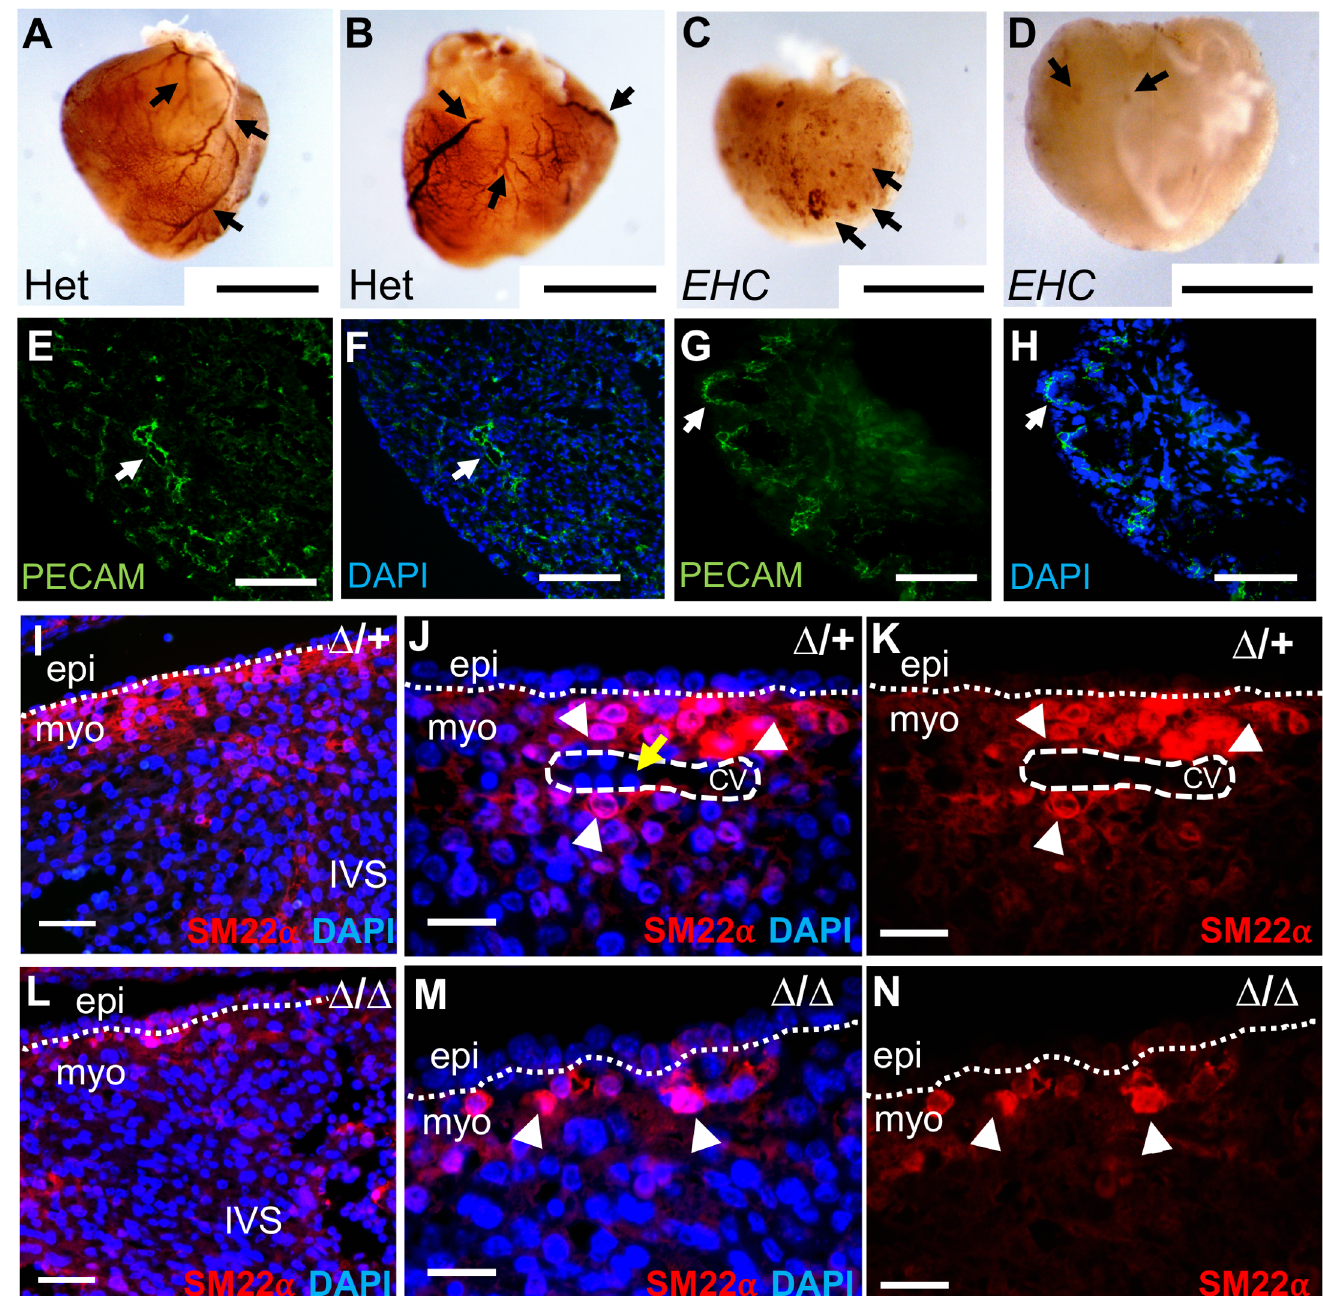
Fig 5. EHC mutants lack mature coronary vessels. PECAM-1 immunohistochemistry reveals prominent coronary vessels (arrows) on the ventral (A) and dorsal(B) surface of EHC heterozygous hearts. Only clusters of PECAM-1 expressingcells (arrows) are apparenton EHC homozygous mutant ventral (C) and dorsal (D) heart surface, with no clear evidenceof coronaryvessels. E-F: Section immunofluorescencefor PECAM-1 (green) on Myh10 Δ heterozygote at E14.5, demonstrating cells in myocardialregion surrounding a developingvessel (arrow). G-H: Section immunofluorescencefor PECAM-1 on Myh10 Δ homozygousmutant at E14.5, demonstrating stainingof clusters of cells on cardiac surface (arrow), consistent with wholemount stainingin panels C-D. Stainingfor the smooth muscle cell marker SM22 α revealsfew smooth muscle cells within the interventricular septum regionof the heterozygote (I) and Myh10 Δ homozygous mutant (L). SM22 α expressingcells are localisedarounda developing coronaryvessel (white dashed circle) in heterozygous control hearts (J-K, arrowheads),and nucleatedblood cells within the vessel can be visualisedwith DAPI (yellow arrow). No such structures are present in Myh10 Δ homozygous mutant hearts, and smooth muscle cells expressingSM22 α are less clusteredin mutant hearts (M-N, arrowheads). Cell nucleiwere labelledwith DAPI (blue). Scale bars: A-D = 1 mm, E-H = 100 μ m, I and L = 50 μ m, J-K and M-N = 25 μ m. Abbreviations: CV: coronary vessel, epi: epicardium,IVS: interventricular septum, myo: myocardium, PECAM: platelet endothelial cell adhesionmolecule-1, Δ : Myh10 Δ . https://doi.org/10.1371/journal.pgen.1007068.g005 PLOS Genetics | https://doi.org/10.1371/journal.pgen.1007068 October 30,